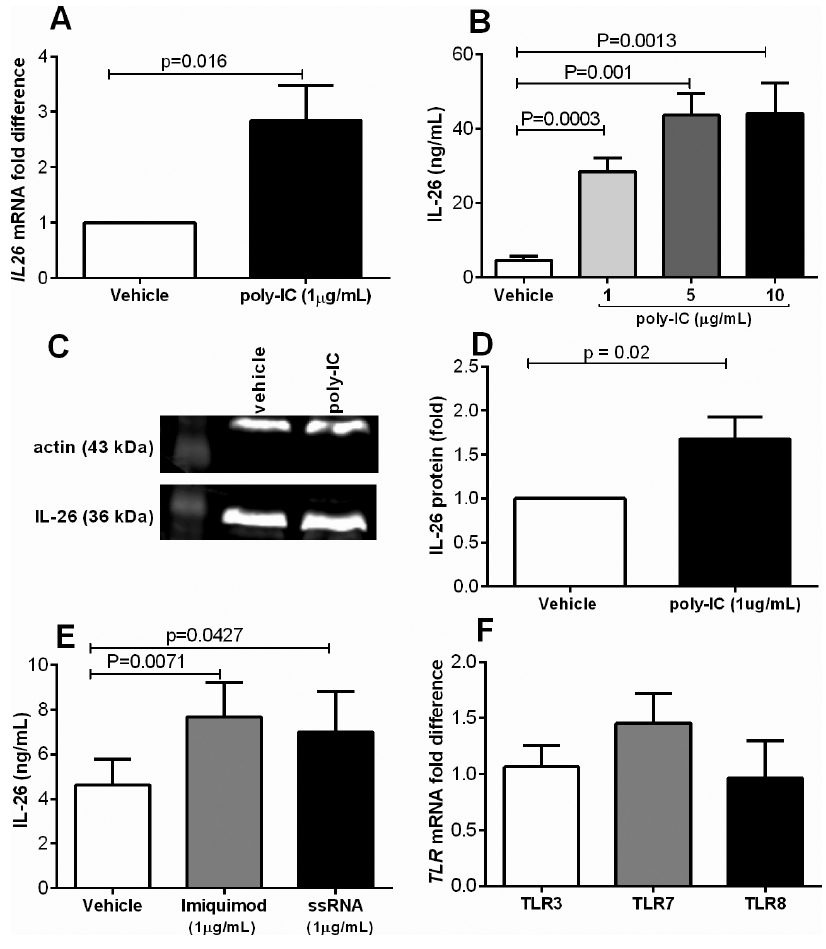
Figure 1 . Primary bronchial epithelial cells produce IL-26 enhanced by viral-related stimuli. Cells were stimulated (24 h) with different viral stimuli (TLR3 agonist poly-IC, TLR7 agonist imiquimod and TLR8 agonist ssRNA). Extracellular concentrations in cell-free conditioned media as well as intracellular expression of IL-26 protein were measured using ELISA and western blot, respectively, and levels of mRNA using real time. (A) IL26 mRNA levels after stimulation with poly-IC (n = 11). (B) Extracellular concentrations of IL-26 in cell-free con- ditioned media in response to poly-IC at different concentrations (n = 8). (C) Intracellular IL-26 protein (representative western blot). (D) the average protein expression (fold differ- ence) after stimulation with poly-IC (1ug/mL) during 24 h. (E) Extracellular concentrations of IL-26 in cell-free conditioned media in response to imiquimod or ssRNA (n = 8). (F) TLR3, TLR7 and TLR8 mRNA levels (fold) (n = 5). The p values indicated are according to the Stu- dent paired t test. p < 0.05 is considered